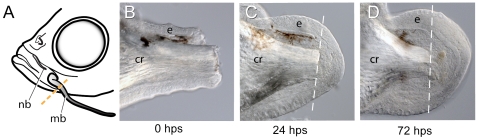
Proximal amputation of the maxillary barbel induces wound healing and blastema formation.
A) Procedure for a unilateral “barbectomy”. The left maxillary barbel (mb) is amputated at the posterior margin of the maxilla. The contralateral barbel (not shown) is left as a non-surgical control. B–D) Fixed, unstained barbel regenerates collected immediately post surgery (B, 0 hps), or after 24 and 72 hours, respectively (C, D). Wound healing is followed by an accumulation of small, rounded mesenchymal cells underneath the epithelium (e) and around the central rod (cr).